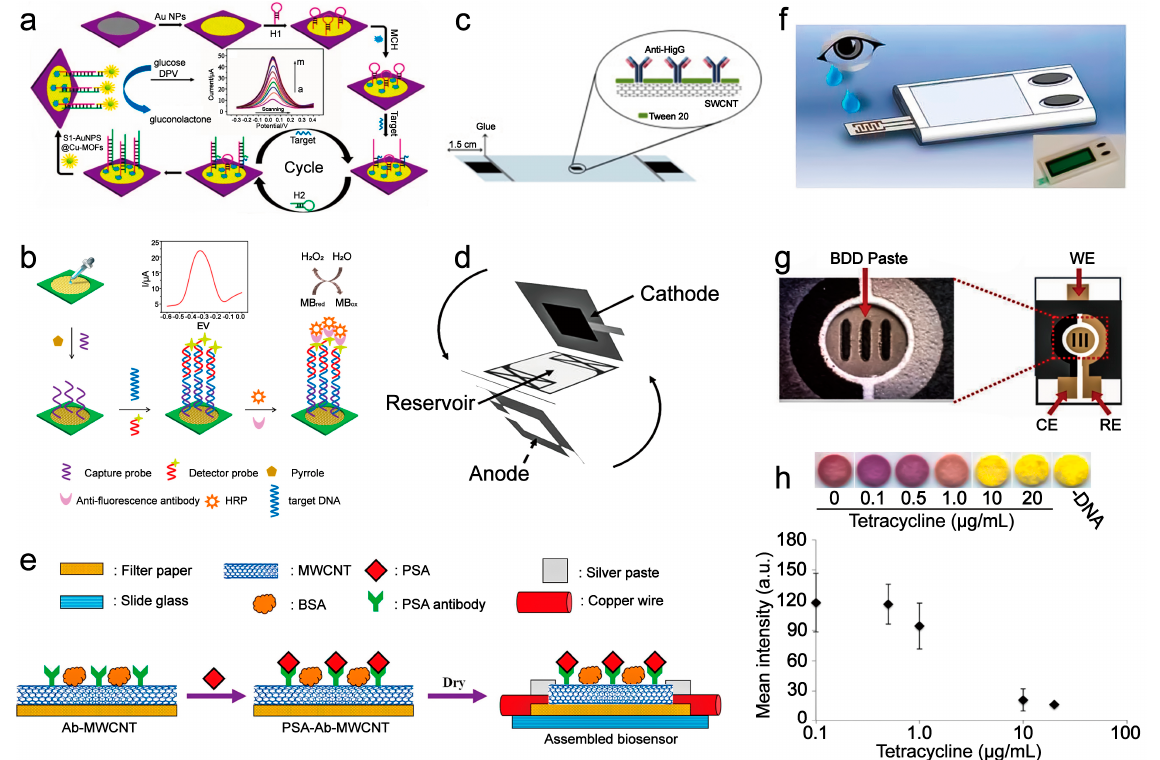
Figure 3. Paper-based sensor for biomolecule sensing. ( a ) Hairpin-assembly signal amplification of the miRNA − 155 bio-sensor. Reprinted/Adapted with permission from Ref. [25]. Copyright 2018 Elsevier B.V. ( b ) Enzyme-based colorimetric detection of EGFR. Reprinted/Adapted with permission from Ref. [12]. Copyright 2017 Elsevier B.V. ( c ) The HIgG chemire-sistor sensor with ideal attachment of the anti-HIgG onto the SWCNTs. Reprinted/Adapted with permission from Ref.